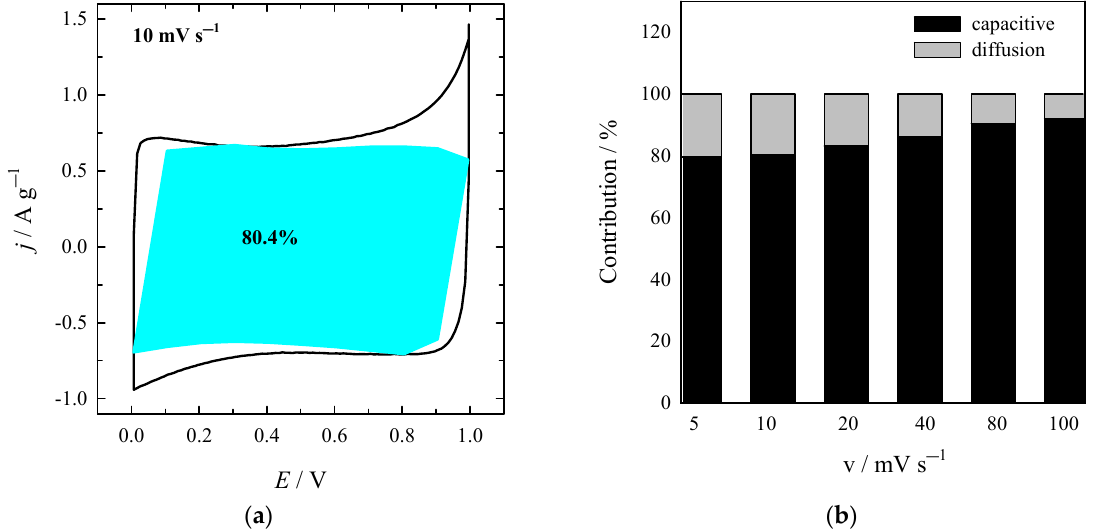
Figure 9. ( a ) The contribution of surface control capacitance at 10 mV s -1 for the NC-ABL-WC and ( b ) the columnar contribution map of surface control capacitance at different scan rates.